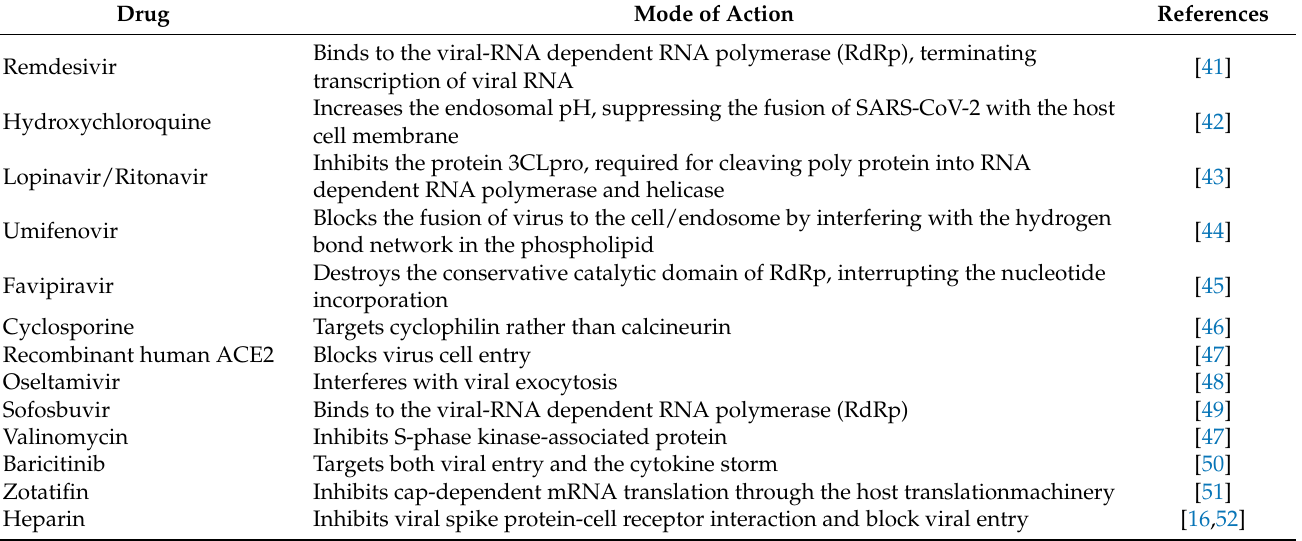
Table 1. Mode of action of several potential antiviral drugs repurposed for COVID-19.